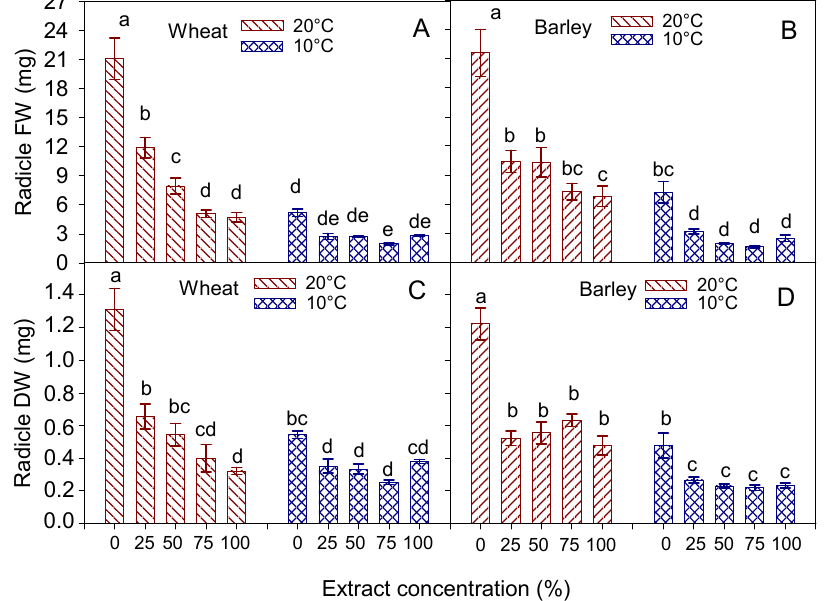
Figure 5. Interaction effect of ‘temperature × extract concentration’ on fresh (FW) and dry (DW) weight of radicle, in wheat cv. Mongibello ( A , C ) and barley cv. Alamo ( B , D ). Data are means ± se ( n = 4). Different letters in barley indicate significance at p < 0.05 according to Tukey’ test.